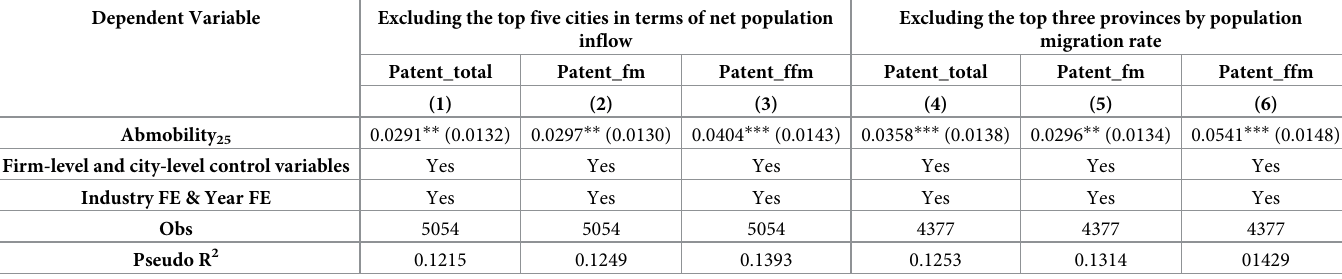
Table 5. Results of controlling population migration. Dependent